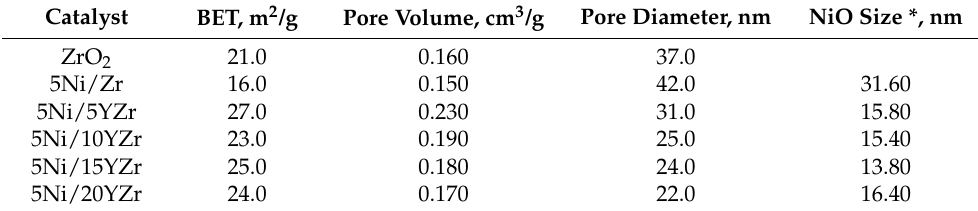
Table 1. The textural features (surface properties) of the catalysts.